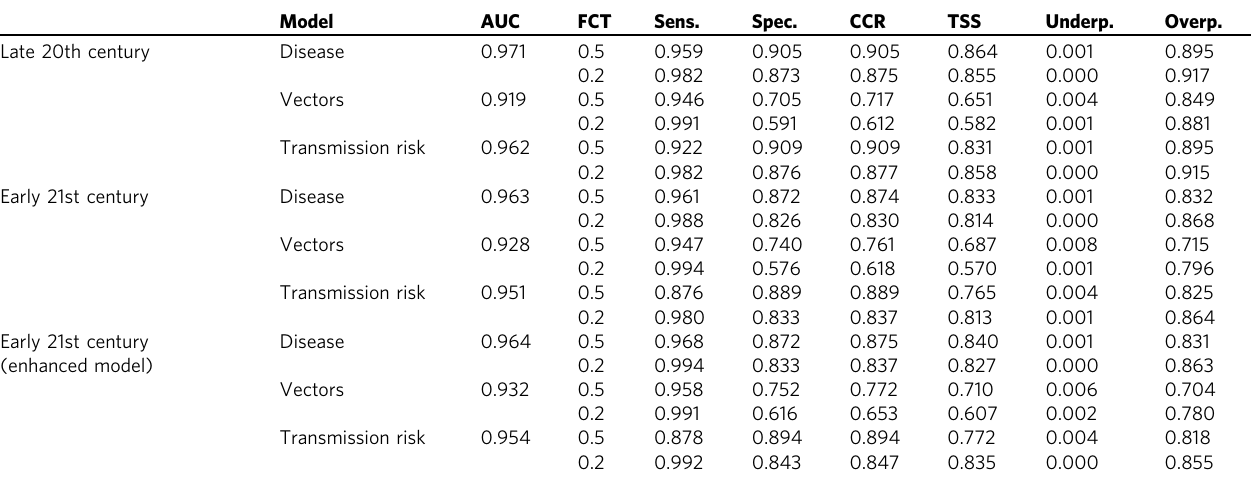
Table 1 Model fi t assessment based on discrimination and classi fi cation capacities respect to vector and disease records of the same period.